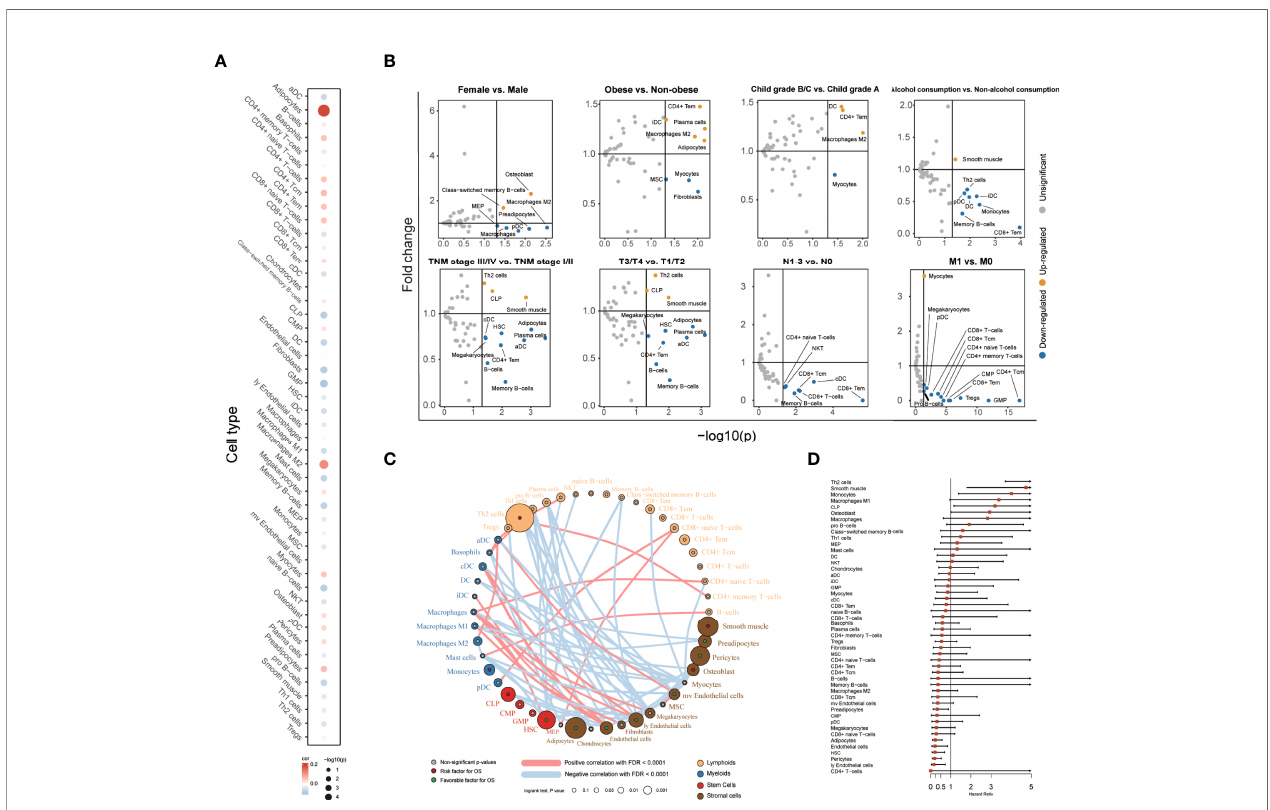
FIGURE 1 | The association between 48 cells in TME and clinical characteristics with patients. (A) Correlation between age and cell score. The size of each cell represented the correlation between age and cell score. Spearman correlation coef fi cients and the associated p-value (Spearman) were shown. (B) Volcano plot diagrams showed the comparison of cell in fi ltration levels. The signi fi cance (p-value) versus and fold change were plotted on the X-axis and T-axis. (C) Landscape of the TME in LIHC. Cellular interaction of the TME cell types. The lymphoid cells are marked by yellow; the myeloid cells are marked by blue; stem cells are marked by red; and stromal cells are marked by brown. The size of each cell represents the survival impact of each TME cell type, which was calculated by log10 (log-rank test p values indicated). Risk factors are indicated in red, and favorable factors for overall survival are indicated in green. The lines connecting TME cells represent cellular interactions. The thickness of the line represents the strength of correlation estimated by Spearman correlation analysis. Positive correlation is indicated in red and negative correlation in blue. (D) Forest plots showing multivariable Cox regression analyses of the cell score, and each score is adjusted by age and TNM